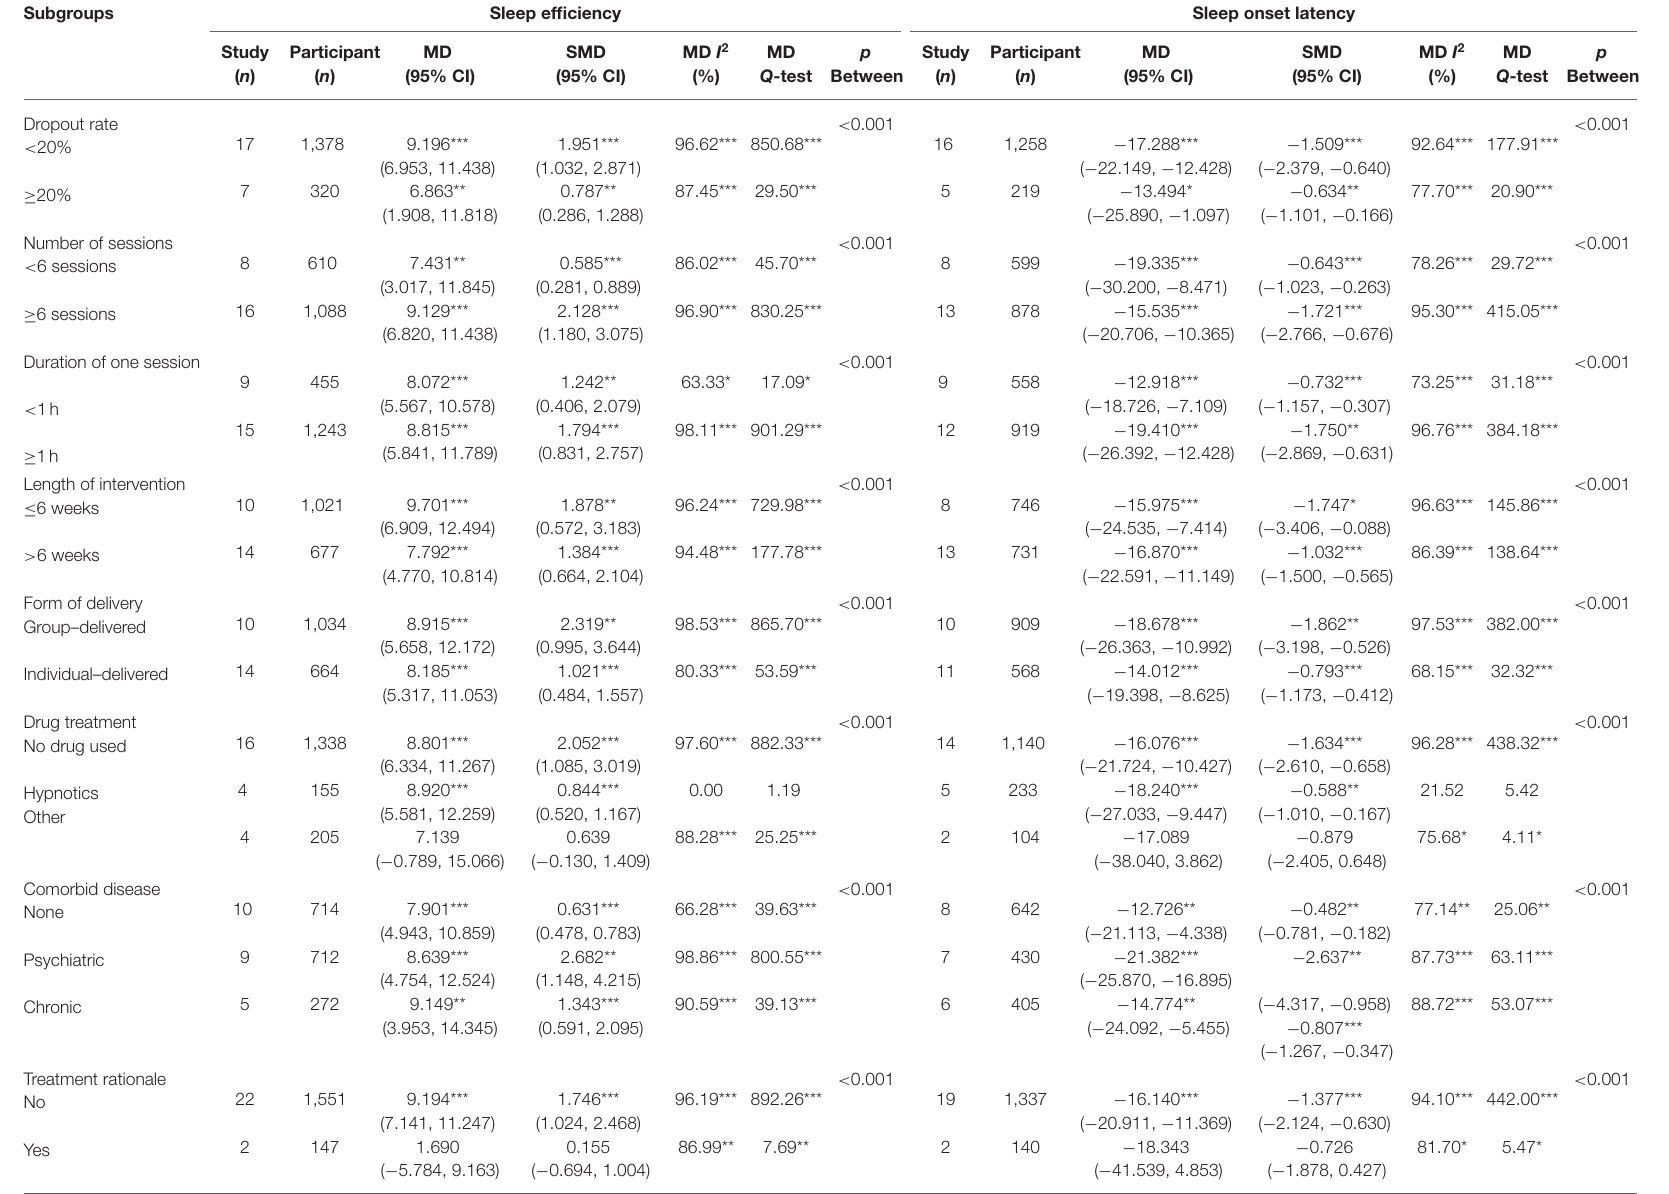
TABLE 4 | Subgroup analysis for sleep efficiency and sleep onset